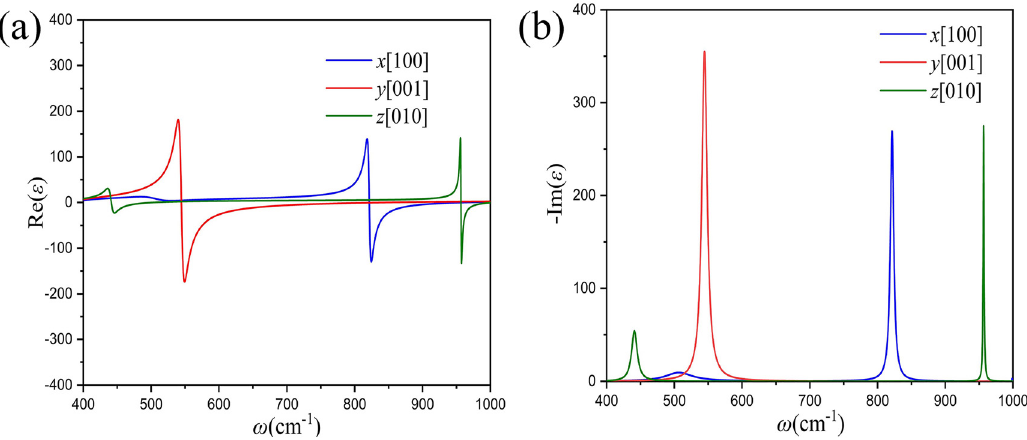
Figure 2: The relation between the (a) real and (b) imaginary part of the permittivity for α -MoO 3 and the frequencies ω